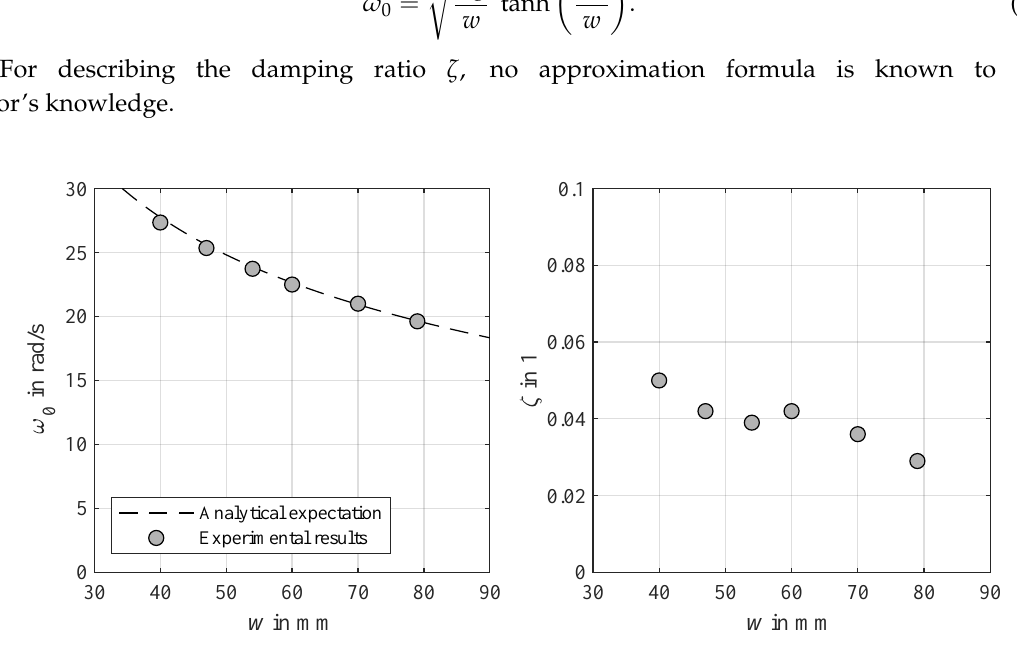
Figure 11. Depiction of derived model parameters ω 0 and ζ dependent on the container’s width w . Furthermore, the analytical expectation of the angular natural frequency is